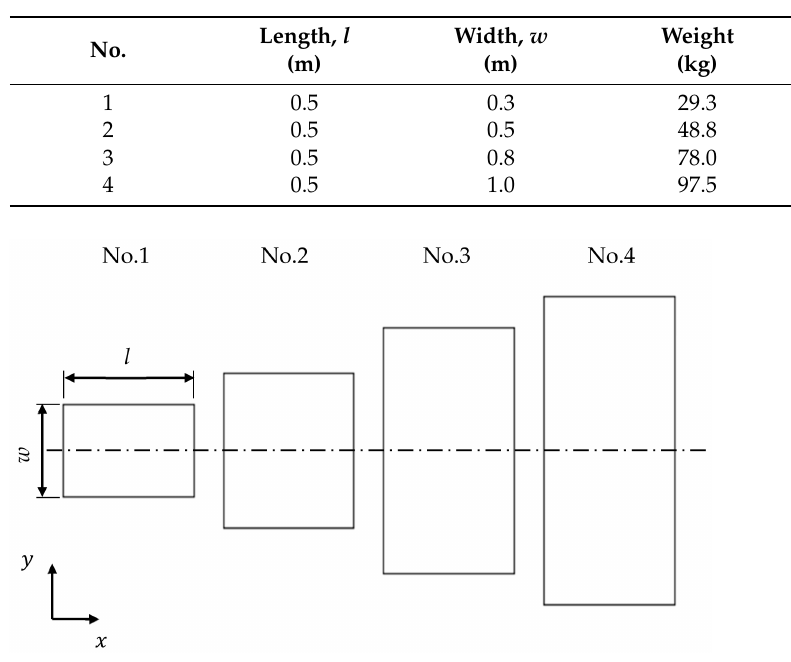
Figure 8. Comparison of moving